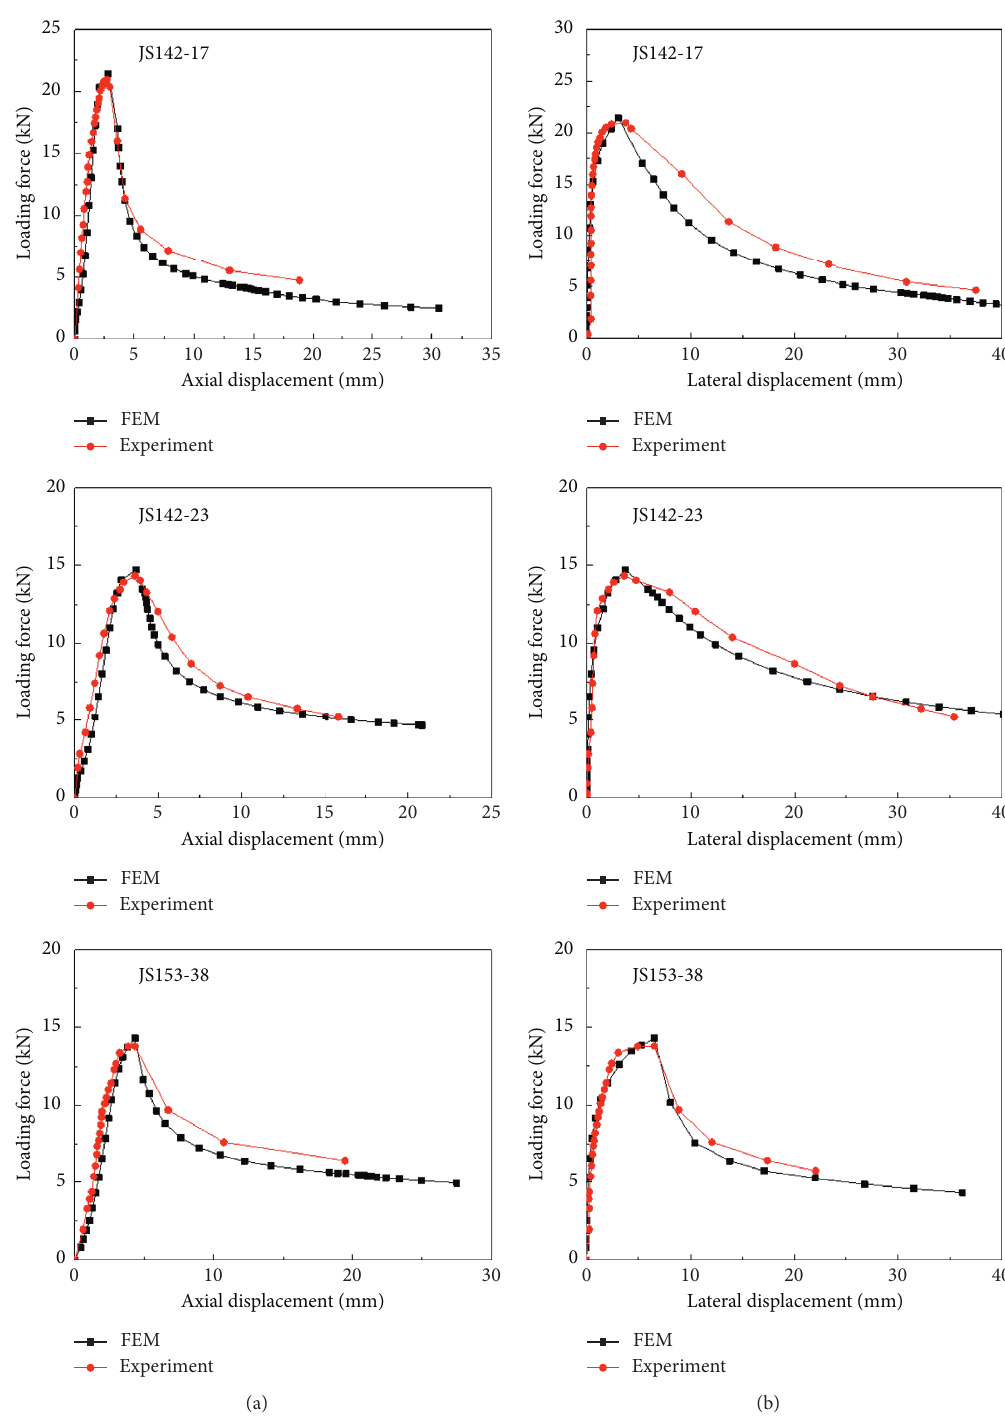
Figure 11: Comparison between finite element simulation and experimental results. (a) Axial displacement; (b) lateral